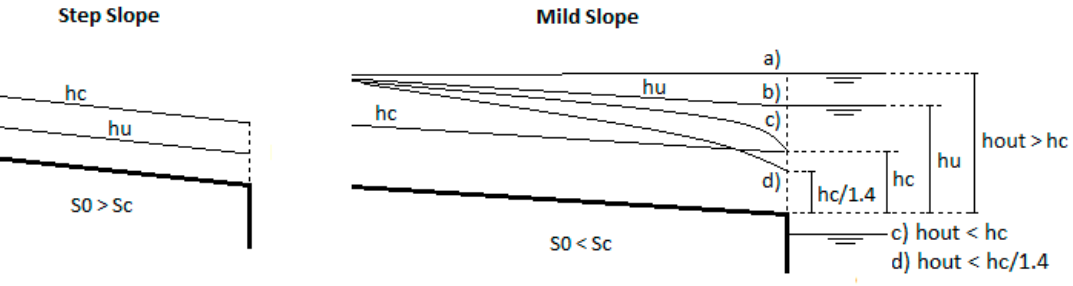
Figure 1. Initial conditions in the links in steady flow, and downstream boundary conditions in subcritical flow controlled downstream with hout > hc (a, b), and free discharge, hout < hc (c), or alternatively hout < hc/1.4 (d).